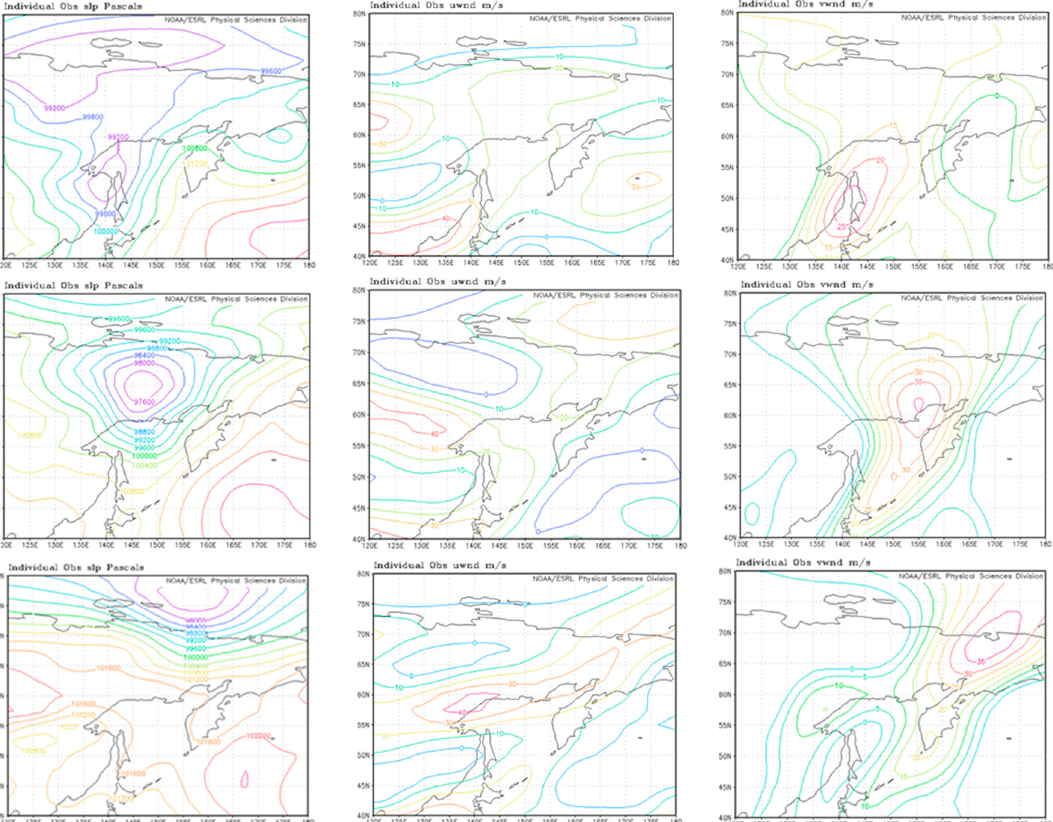
Figure 3. The ( a , d , g ) sea level pressure (Pa) (left column), ( b , e , h ) u-wind component (m s -1 ) (middle column), and ( c , f , i ) v-wind component (m s -1 ) (right column) for 1200 UTC 25 August (top row), 1200 UTC 26 August (middle row), and 1200 UTC 27 August 2016 (bottom row),